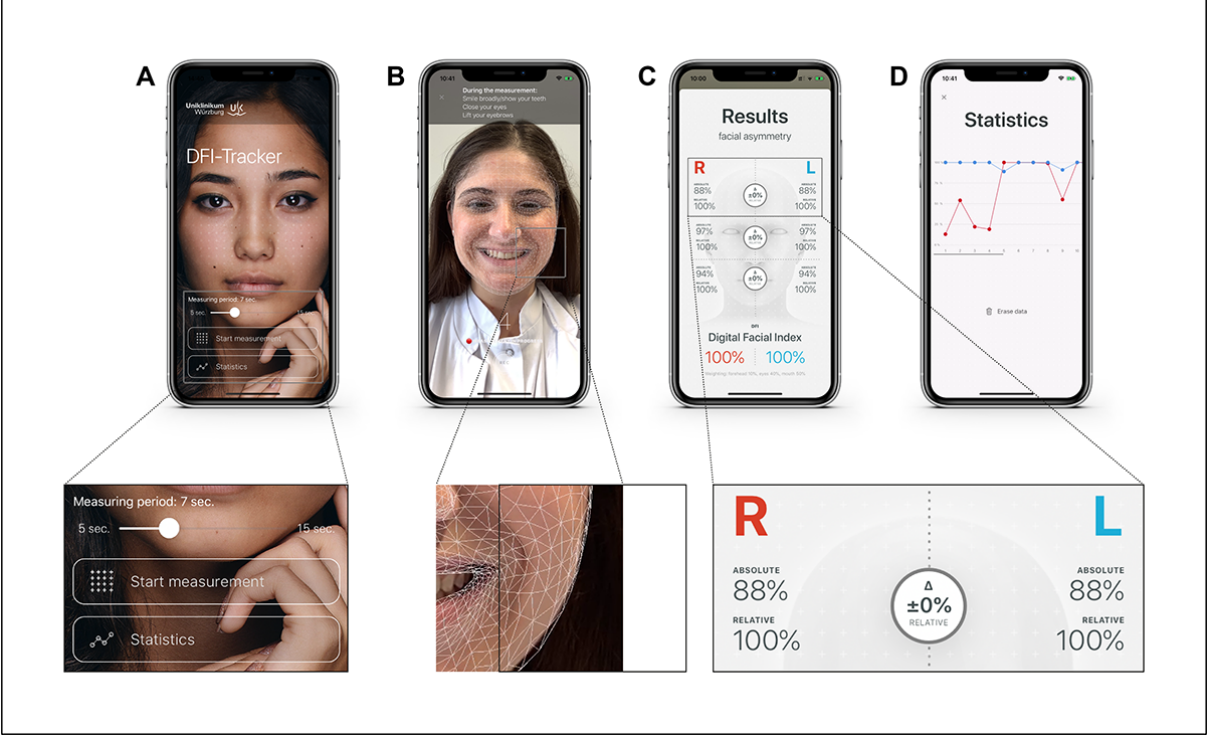
Figure 5. User interface of the Digital Facial Index (DFI) Tracker App, including the (A) start screen with a setting for the measurement duration (5 to 15 seconds) and buttons to get to the measurement mode or statistics; (B) measurement mode with a real-time polygon grid overlay for immediate feedback on the precise registration of the user’s face; (C) results showing absolute and relative values, their difference, and calculated DFI values; and (D) statistics with a simple graphical representation of the last measured values. The depicted author provided written informed consent for her photos to be used for this